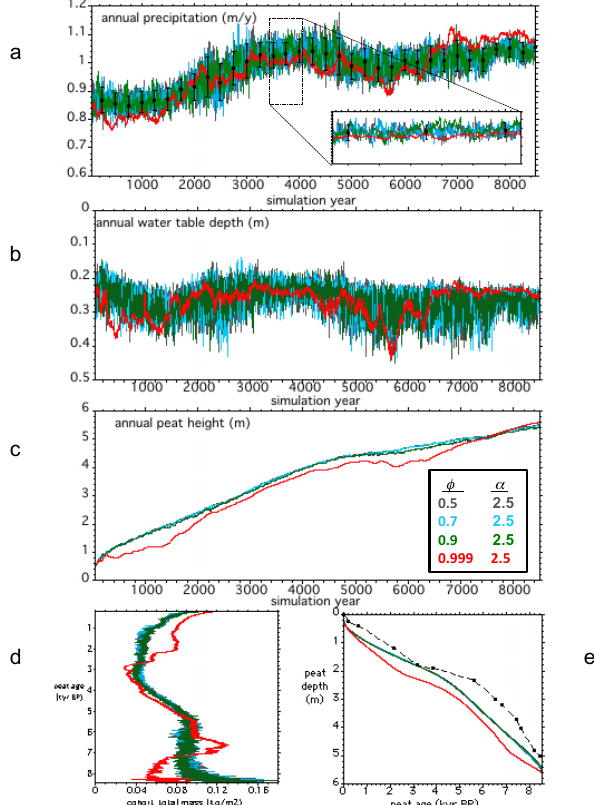
Fig. 7. HPM sensitivity to precipitation variability. (a) Four man- ifestations of annual precipitation (my − 1 ) with amplitude of ran- dom variability α (see Eq. 20) values of 1.0 (dark gray), 1.5 (cyan), 2.0 (green), and 3.0 (red) (see text and Eq. 19) and φ =0.99. In base runs (Figs. 4–6) α =2.5 and φ =0.99. Solid black circles are regional mean annual precipitation at 250-year intervals, bars are regional variance, as determined by Muller et al. (2003b). Inset is zoom-in for simulation years 3450–4050, inset precipitation range 0.85–1.15my − 1 . (b) Simulated annual water table depth (m below peat surface). (c) Simulated annual peat height. (d) Simulated fi- nal cohort mass. NOTE: these values are cohort mass in kgm − 2 , not cohort carbon content, kgCm − 2 as in Fig. 5b. (e) Simulated age-depth profile, and dates from core MB930. NOTE: panels (a– c) start with simulation year 50, avoiding the peatland initialization period (see text), and panel (d) is for peat ages 200–8450BP, avoid- ing the peatland initialization period (roughly 8450–8500BP) and the most recent 200 years, where, due to lack of time to decompose, peat cohort masses get much larger than those shown in the figure.